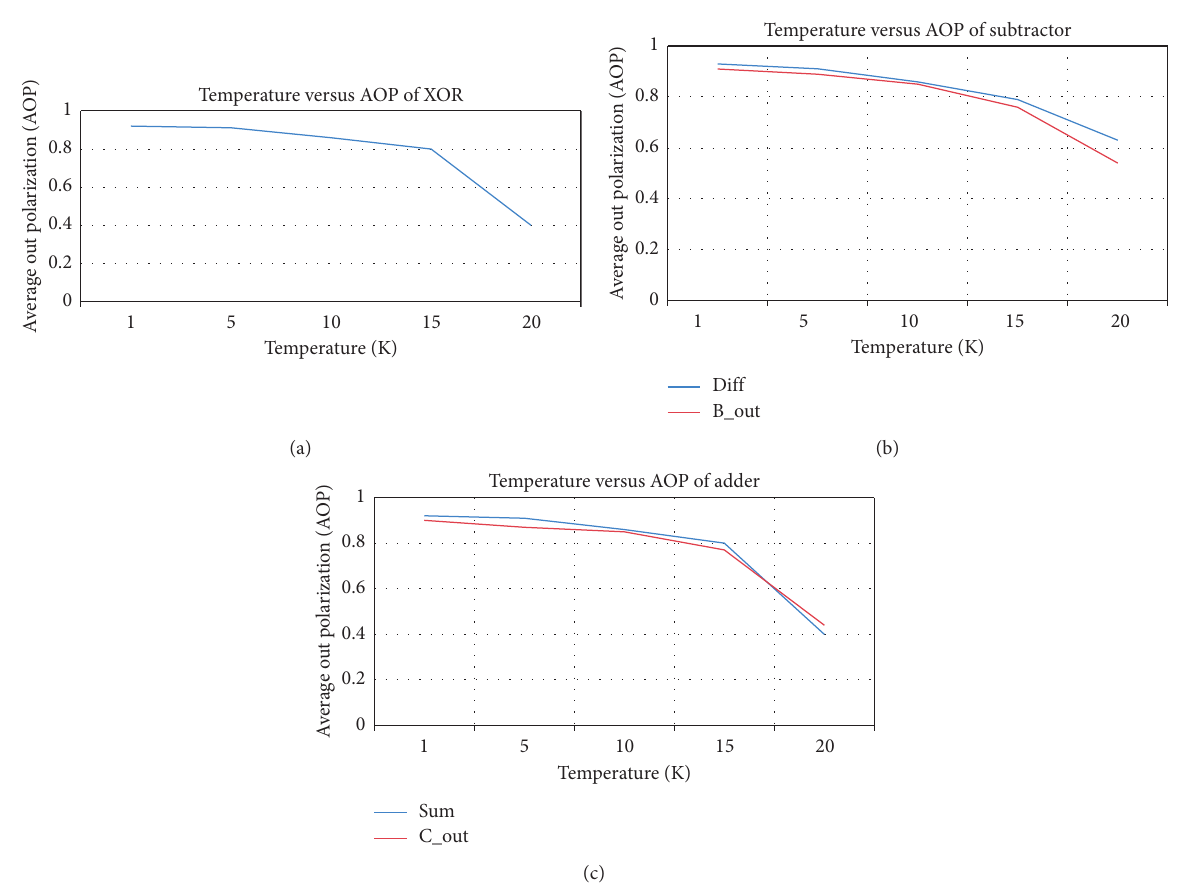
Figure 9: The calculated average output polarization (AOP) of the proposed designs against temperature Tin Kelvin. (a) Three-input XOR gate, (b) subtractor for outputs ‘‘B_out” and ‘‘Diff,” and (c) adder for outputs ‘‘Sum” and ‘‘C_out.”